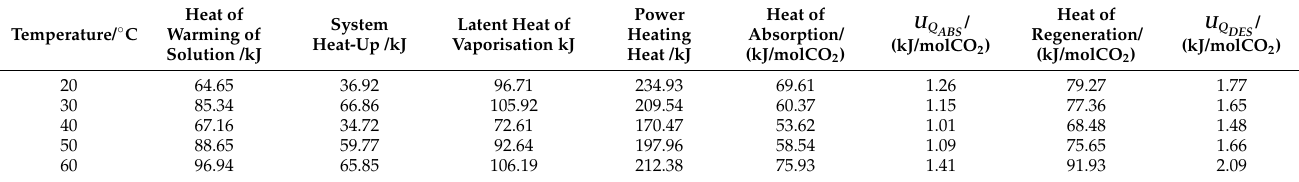
Table 11. Reaction heat data of AEP-DPA at different